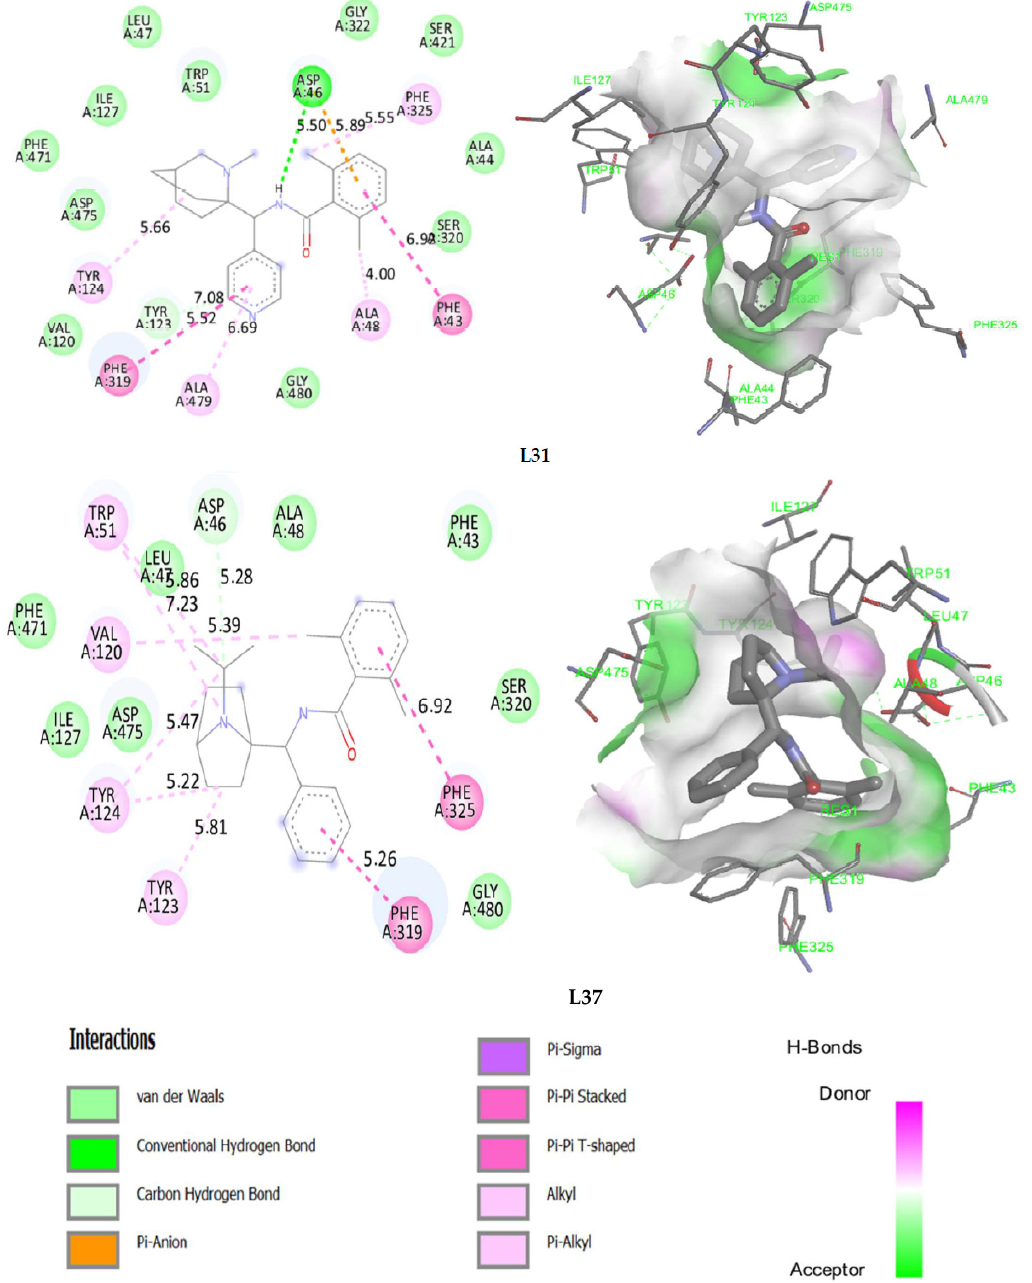
Figure 8. 2D and 3D visualization of intermolecular interactions between DAT (PDB code: 4M48) and the more active ligands (L6, L9, L30, L31 and L37), with binding energies of − 10.74 kcal/mol, − 10.22 kcal/mol, − 8.46 kcal/mol, − 8.78 kcal/mol and − 8.59 kcal/mol,